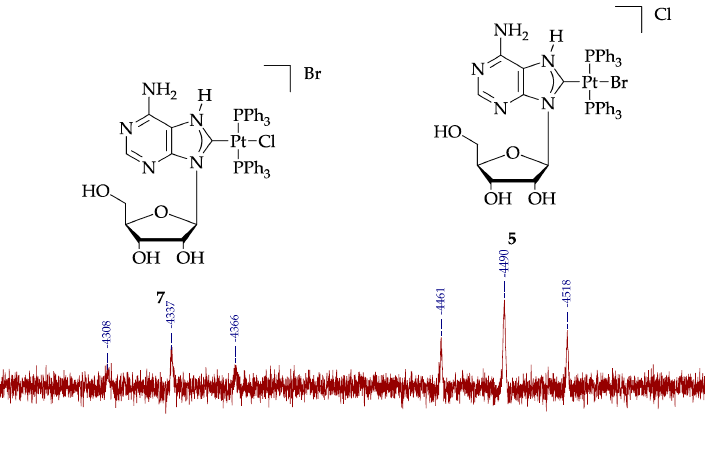
Figure 2. 31 P NMR spectrum of complex 5 in DMSO- d 6 at room temperature, after 4 days in solution.